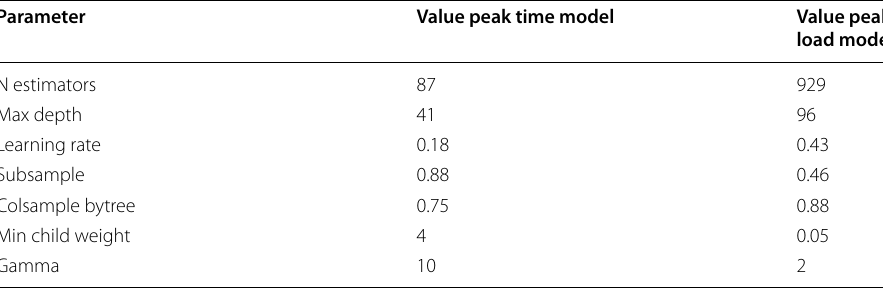
Table 6 Final XGBoost parameters for peak time and peak load